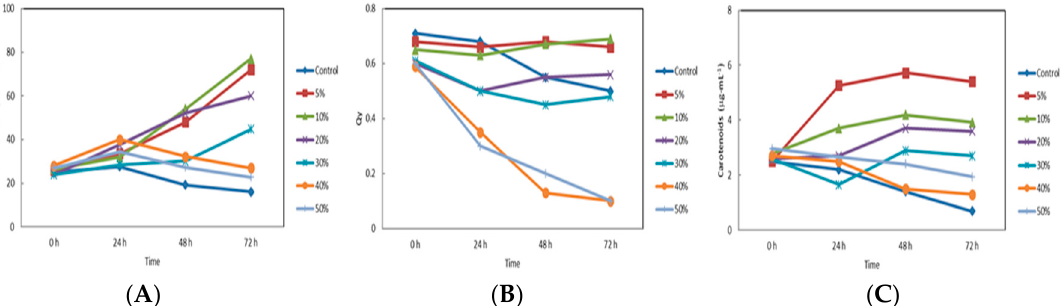
Figure 1. Evolution of chlorophyll, quantum yield and total carotenoid content in C. sorokiniana cultures prepared with MSN at different concentrations. Cell cultures of the microalgae were incubated with media obtained by extraction of wine residues (MSN) at 5, 10, 20, 30, 40 and 50% w / v . Both cultures were inoculated with 25 µg Chl/mL, with 100 µmol of photons/m 2 /s of white light, incubated at a temperature of 25 °C and were fluidized with air enriched in CO 2 (5% v / v ). Chlorophyll content (µg mL − 1 ) ( A ); quantum yield (QY) ( B ) and total carotenoid content (µg mL − 1 ) ( C ) were calculated throughout the experiment as indicated in Materials and Methods section.